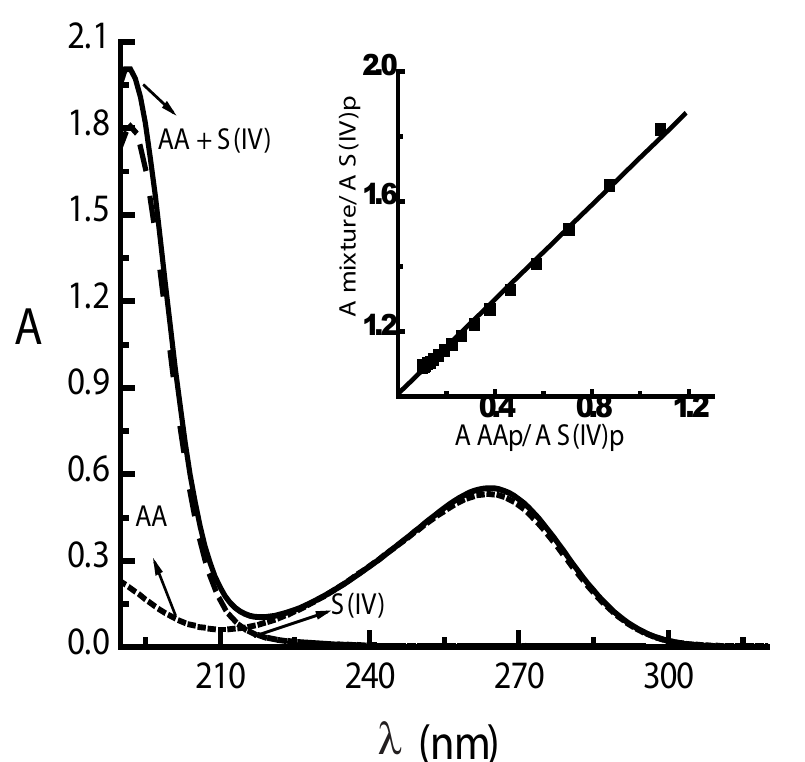
FIGURE 6 – Absorption spectra of solutions containing 50 μM AA, 500 μM S(IV) and mixture (50 μM AA + 500 μM S(IV)). pH = 5.5. Water as reference solution. 1.0 cm pathlength (quartz cuvette). Figure inserted: A A ; r 2 = S(IV)p